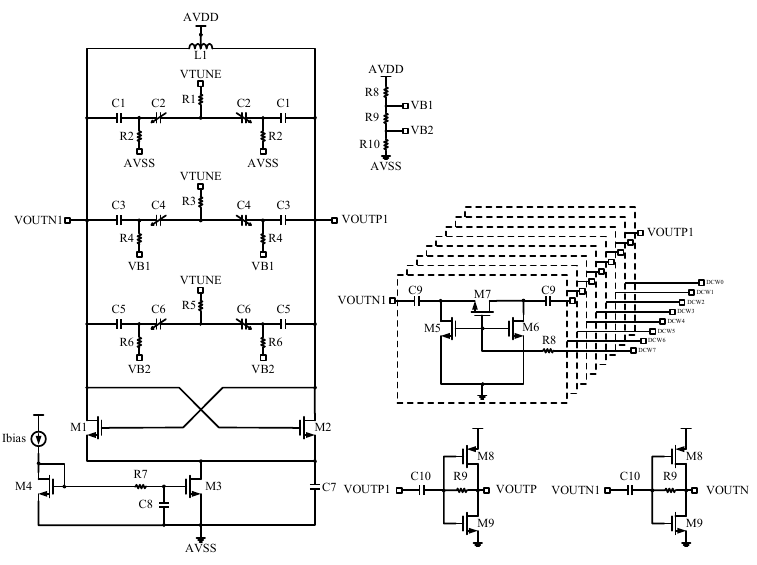
Figure 6. VCO topology.